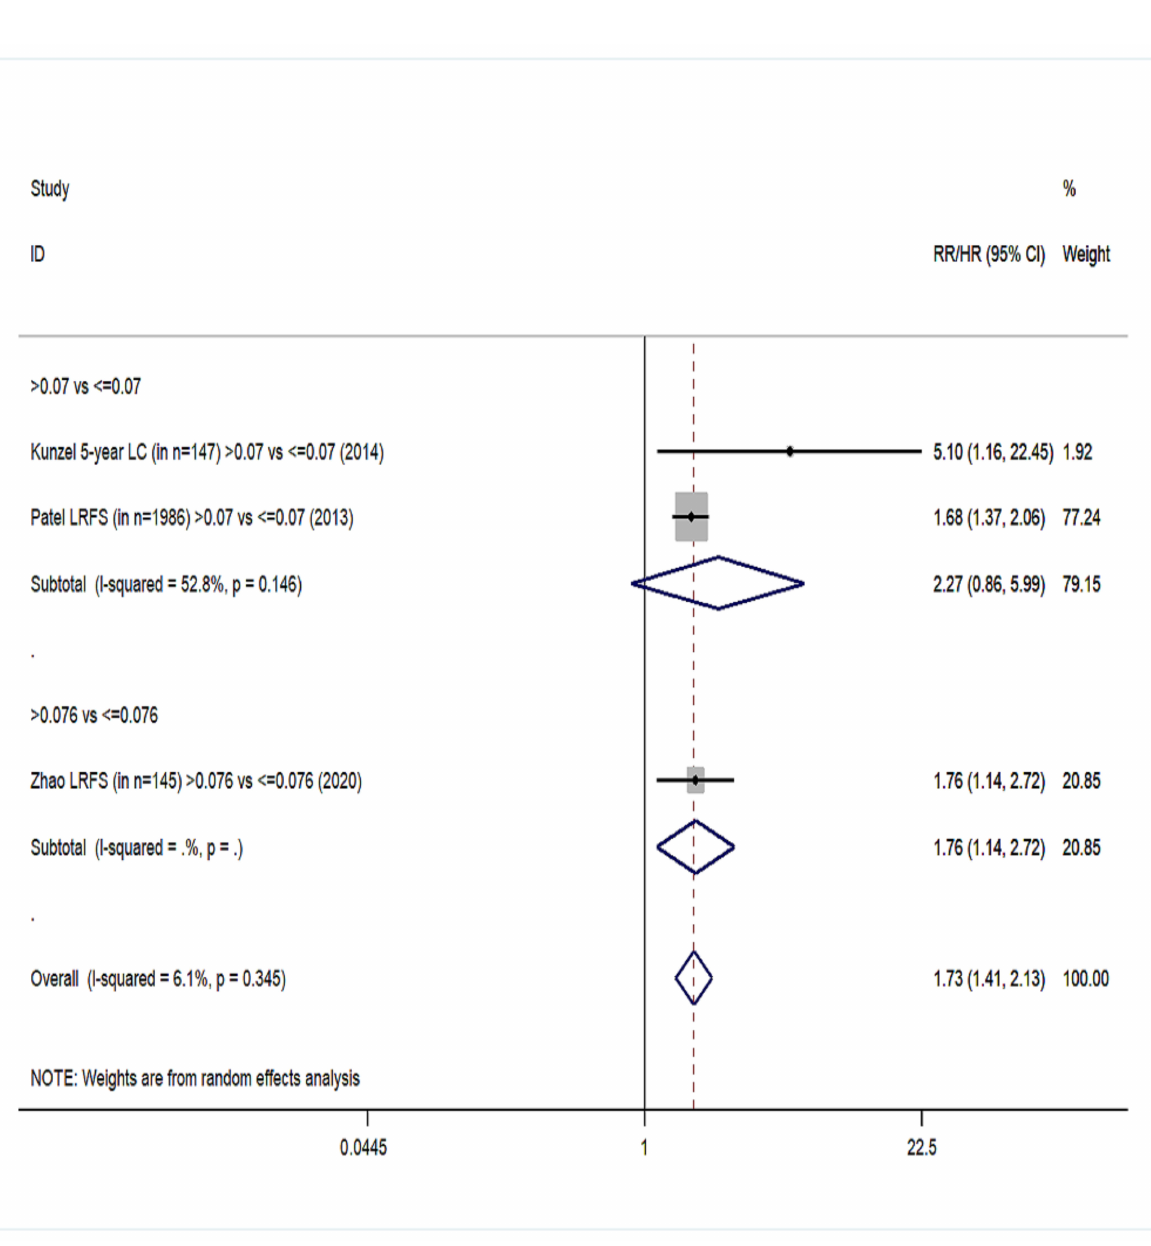
Figure 7. Forest plot showing the associations between lymph node ratio (LNR) and local recurrence- free survival (LRFS) in group YES. Apart from the overall analysis, the subanalyses by LNR cut-off values are